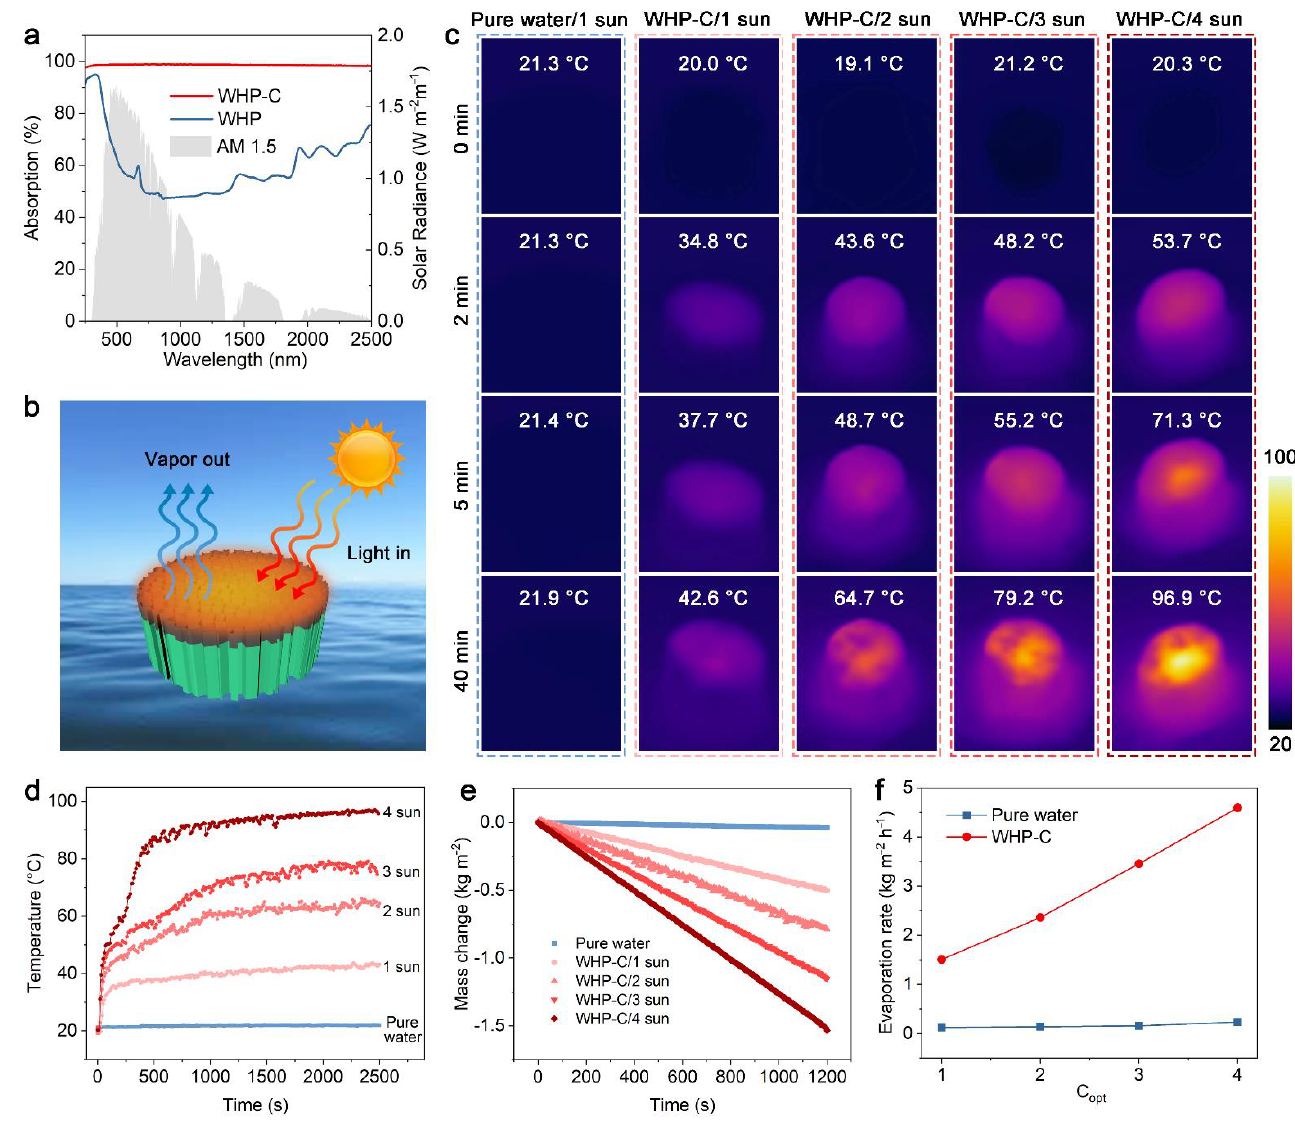
Figure 4. ( a ) UV-Vis-NIR spectra of WHP and WHP-C. The normalized spectral solar irradiance density of the air mass 1.5 global (AM 1.5 G) tilt solar spectrum is shown by the gray area. ( b ) Schematic illustration showing the solar-driven vapor generation by WHP-C. ( c ) Infrared images showing the temperature distribution and changes of pure water under 1 sun irradiation and the WHP-C under different intensities of light (1, 2, 3, 4 sun). The ( d ) maximum surface temperature and ( e ) mass changes of pure water under 1 sun irradiation and the WHP-C under different intensities of light (1, 2, 3, 4 sun). ( f ) The evaporation rates of pure water and the WHP-C under different intensities of light (1, 2, 3, 4 sun). C opt represents the light concentration coefficient of the xenon